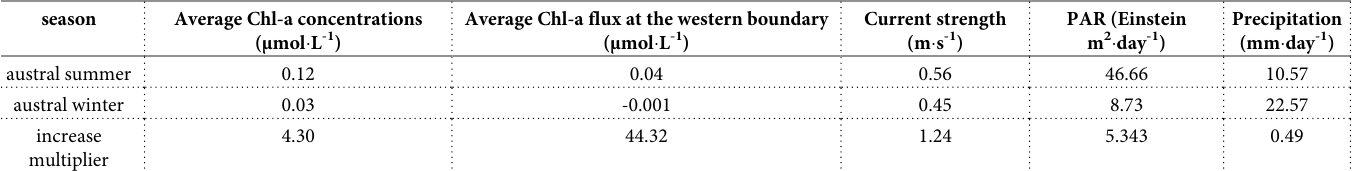
Table 2. Comparison of Chl-a data, Chl-a flux, current flow, PAR, and precipitation data in box B. season Average Chl-a concentrations ( μ mol � L -1